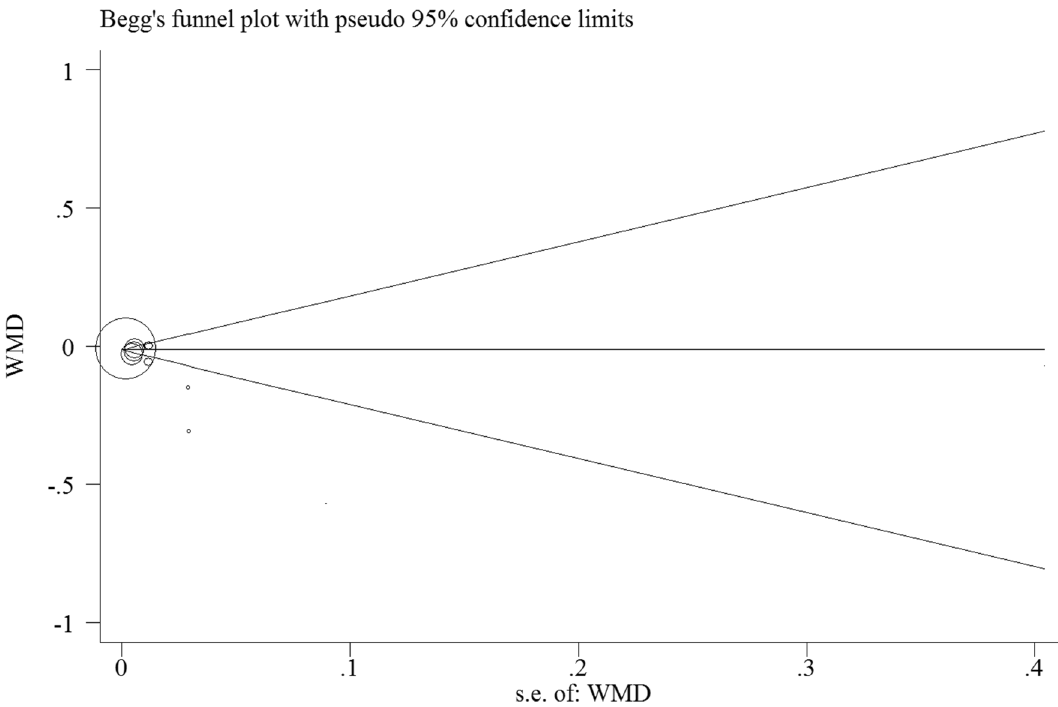
Figure 3. Funnel plot of the weighted mean difference (WMD) versus the s.e. of the weighted mean difference (WMD). All statistical analyses were performed using Stata version 14 (StataCorp. 2015. Stata